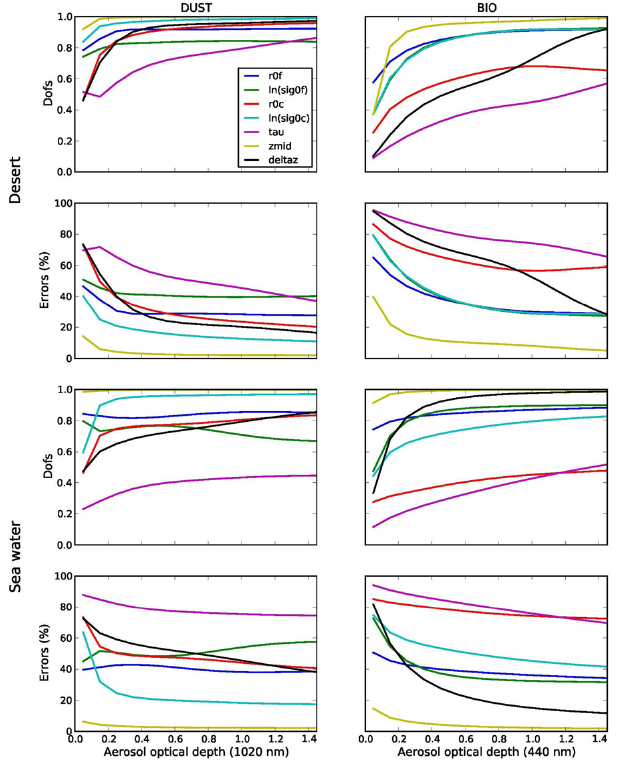
Fig. 5. DOFSs and total error (in %) for each aerosol parameter of the state vector considering selected channels (see text for details). τ is AOD, r mean radius, and ln( σ) deviation of the radius. The f and c indices are for fine and coarse mode respectively. Z mid and 1Z are center height and width of the aerosol